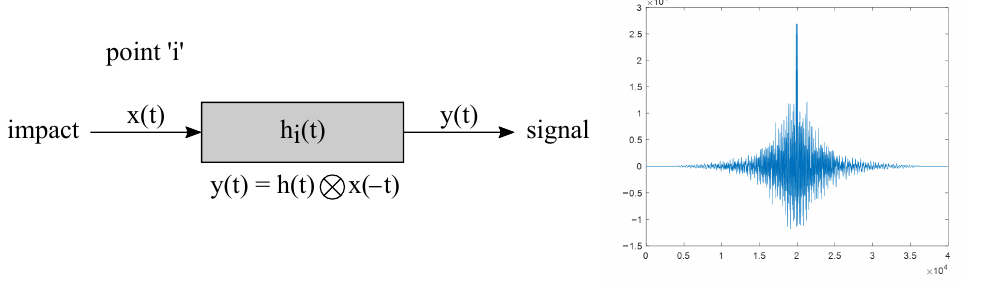
Figure 8. Virtual time reverse